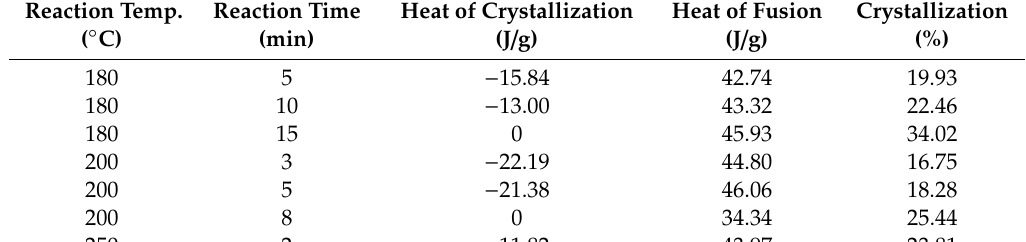
Figure 4. Differential scanning calorimetry (DSC) analysis of polylactic acid (PLA). ( a ) Untreated PLA and ( b ) decomposed PLA at 180 °C for 10 min. Table 3. Heat of crystallization and heat of fusion of polylactic acid (PLA). Table 3. Heat of crystallization and heat of fusion of polylactic acid (PLA). Reaction Temp. Reaction Temp.